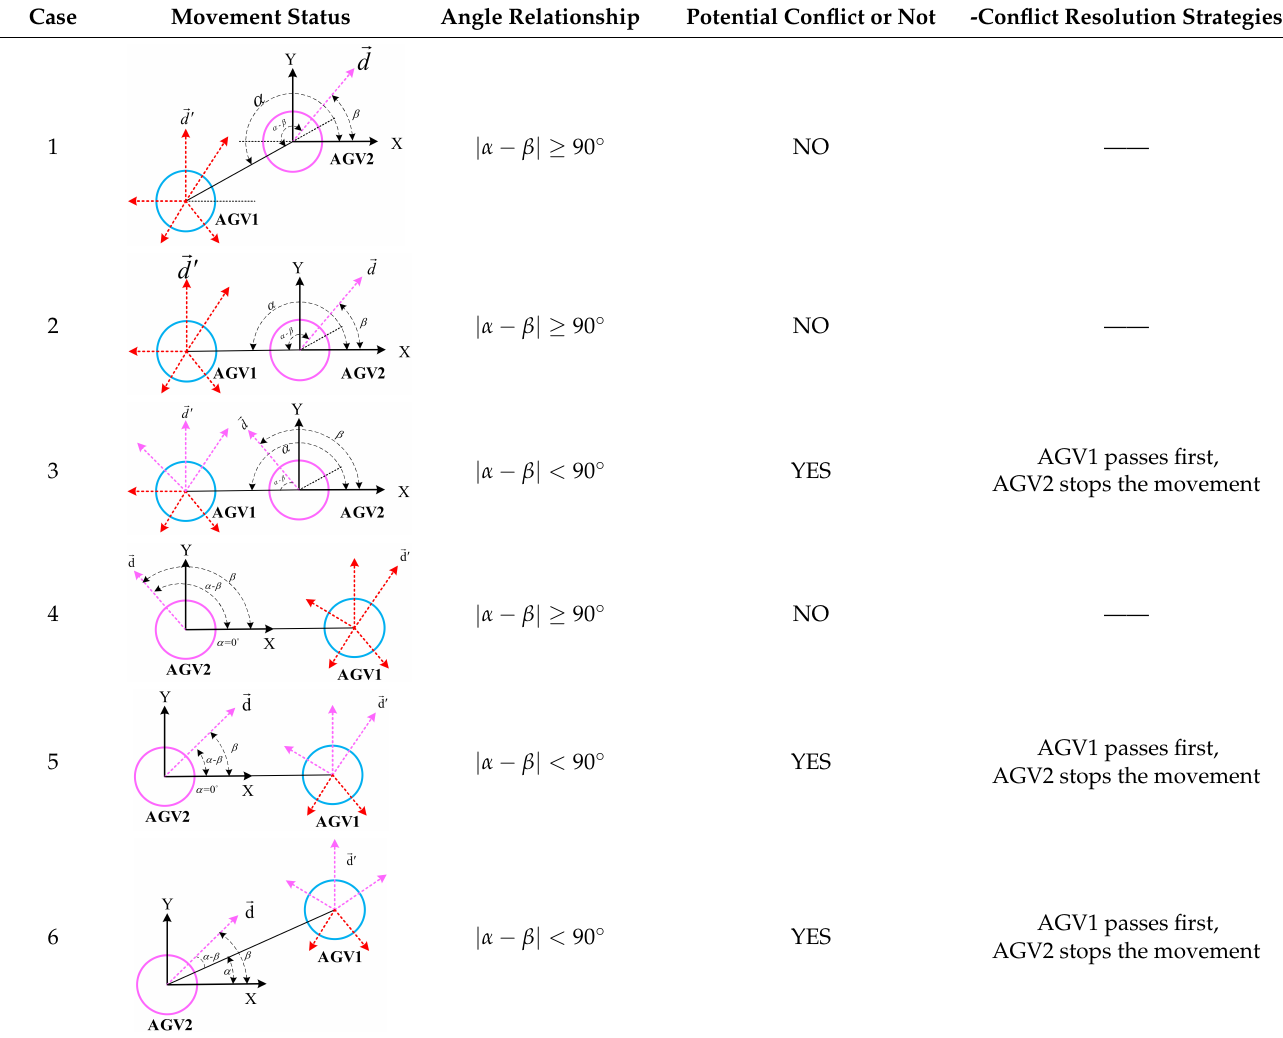
Table 1. Multi-robot motion conflict detection and resolution scenarios.